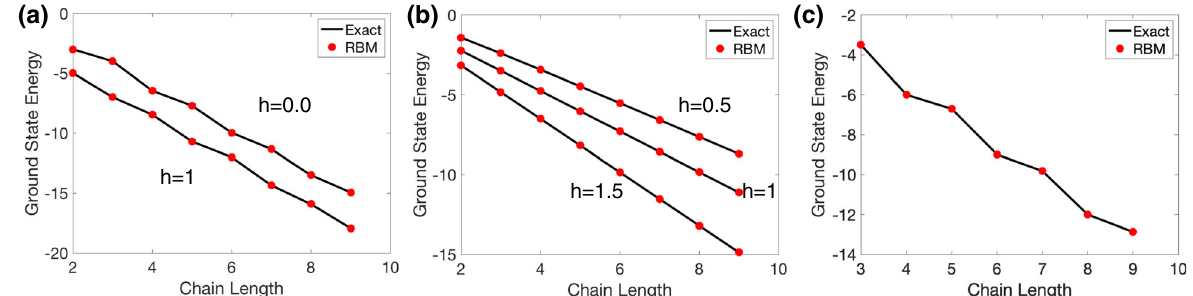
Fig. 3 Numerical results for spin systems. The ground state energy of spin chains computed with the NQS-ITE algorithm (solid red dots) and exact diagonalization (solid black lines). Results for a Heisenberg chain as a function of chain length at different values of h fi eld, b Ising chain as a function of chain length at different values of h fi eld, c J1 – J2 chain with J1 = 1 and J2 = 0.5. In panel a , the result for h = 1 has been shifted downwards by 2 units for